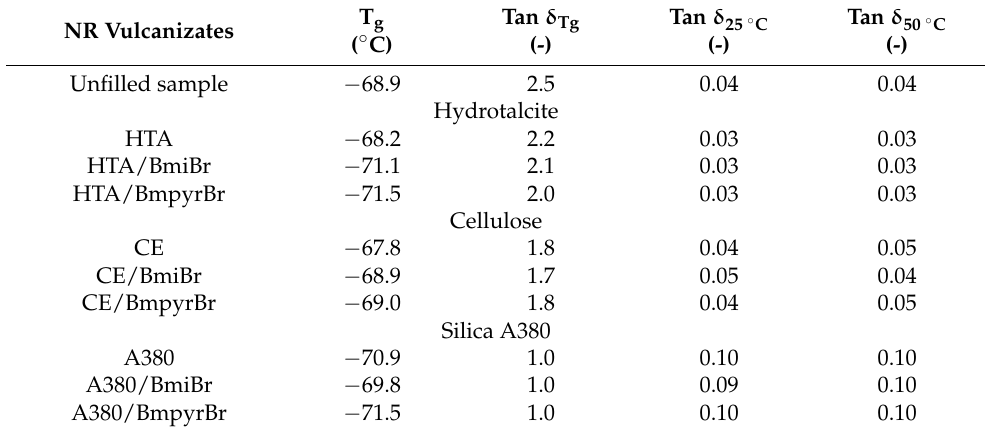
Table 8. Glass transition temperature (T g ) determined by dynamic mechanical analysis (DMA)